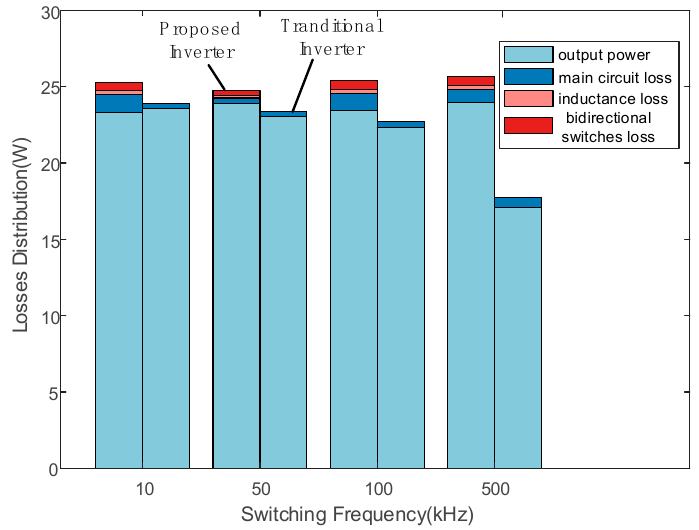
Figure 12. Comparison of power distribution in different frequencies.